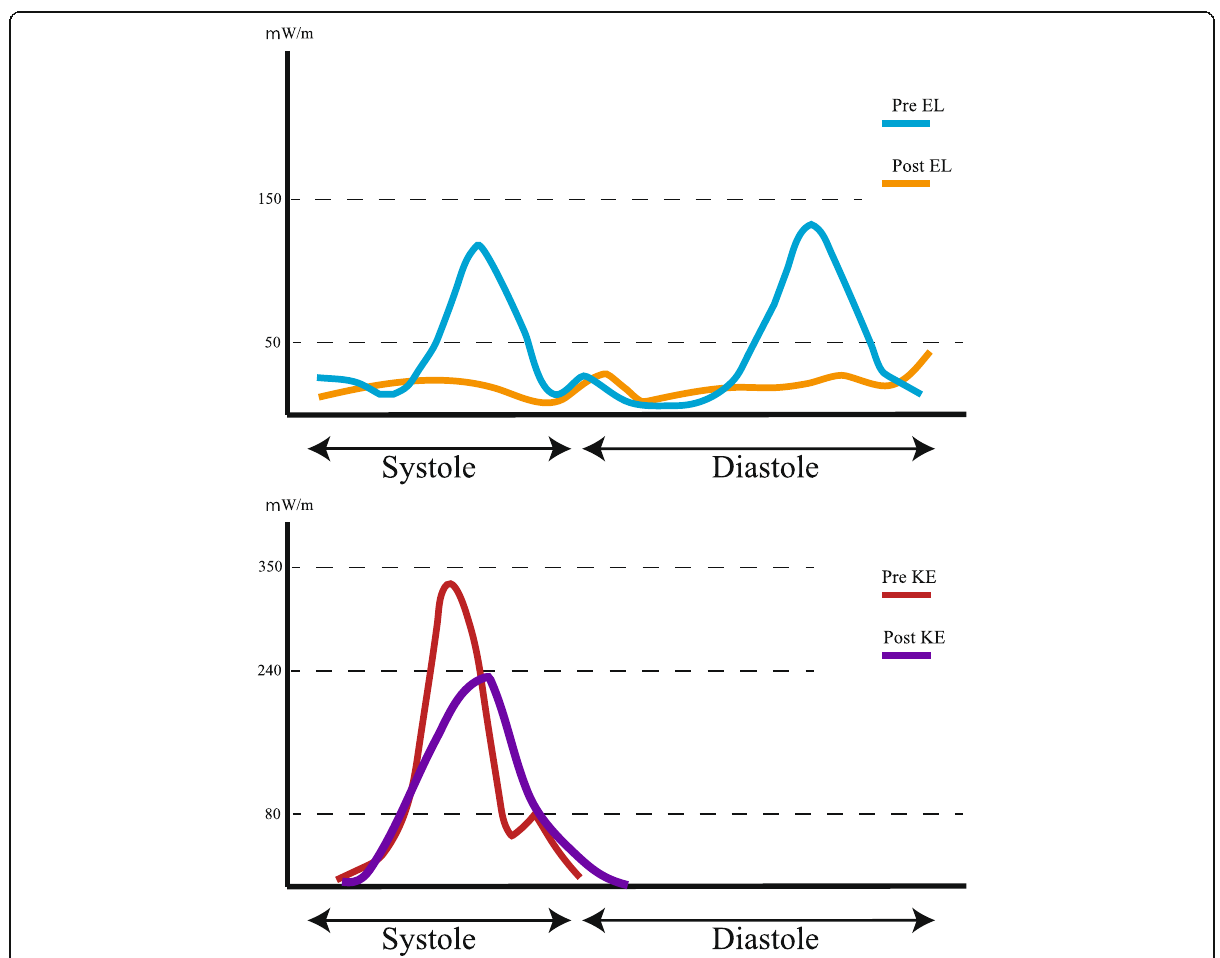
Fig. 3 Flow energy loss (top) and flow kinetic energy (bottom) during one cardiac cycle. Upper graph demonstrates the pattern of flow energy loss during one cardiac cycle. The blue line presents preoperative energy loss, and the yellow line represents postoperative energy loss. Lower graph demonstrates the pattern of flow kinetic energy of the left ventricle during one cardiac cycle. The red line presents preoperative kinetic energy, and the purple line represents postoperative energy